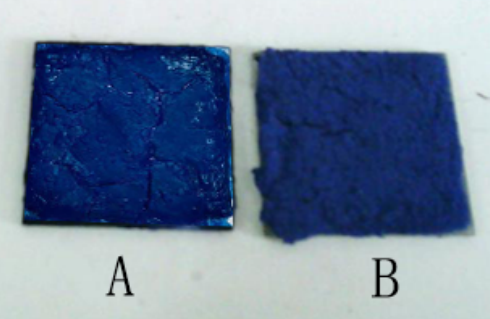
Figure 12. The digital photos of sample A (normal colored latex paint coating and sample B (novel colored latex paint coating containing paraffin@SiO 2 colored microcapsules).